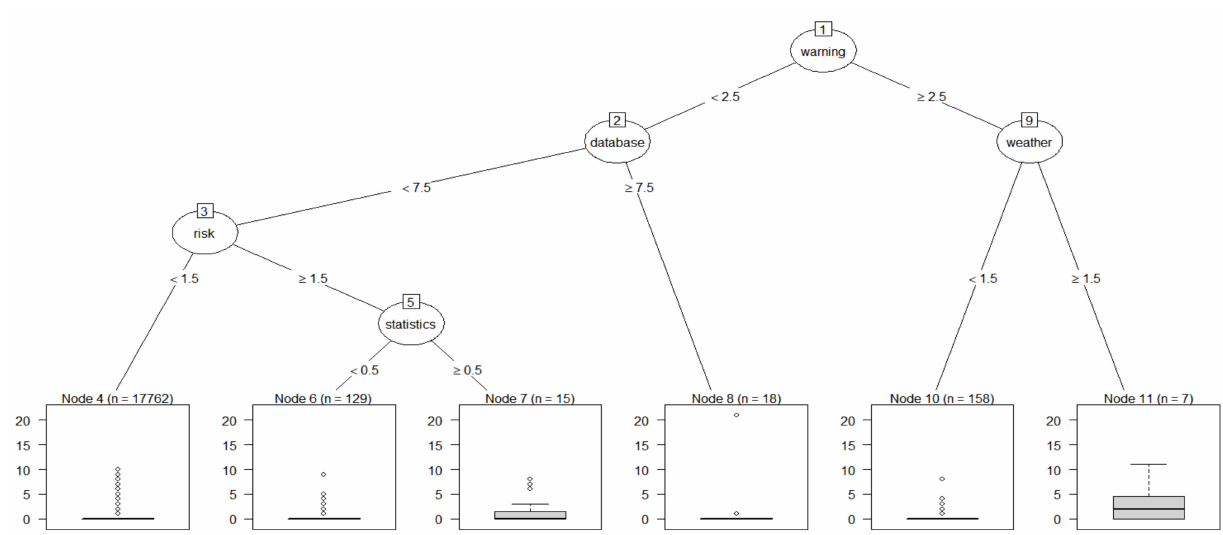
Figure 5. Regression tree plot of disaster.